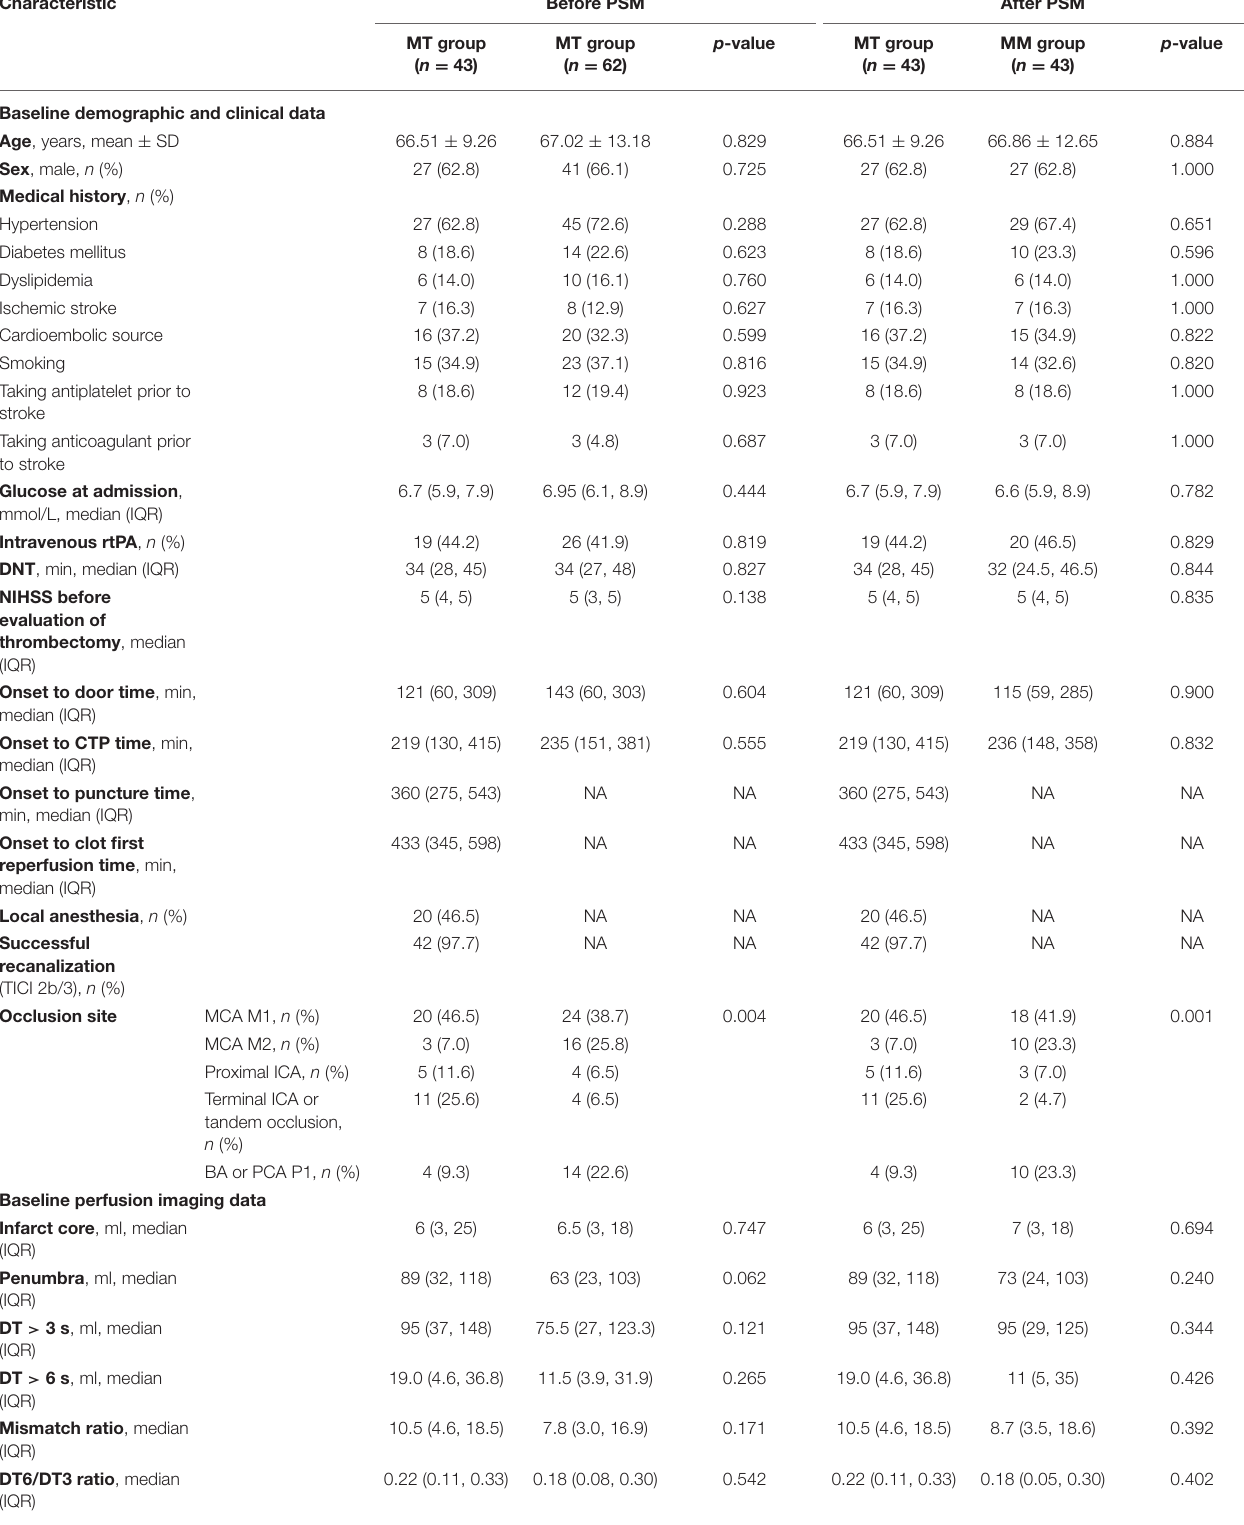
TABLE 1 | Comparisons of baseline clinical profiles and CTP data between thrombectomy and medical management groups before and after PSM.